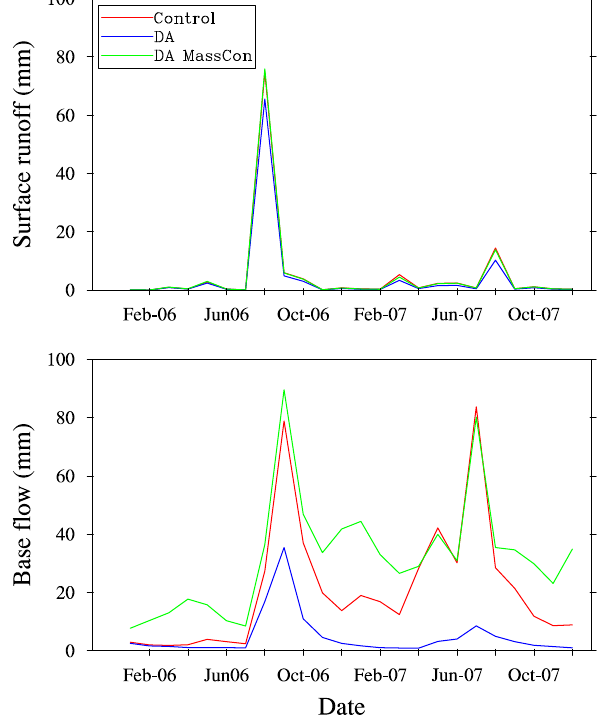
Fig. 8. Monthly surface (top panel) and base flow (lower panel) from Control, DA and DA